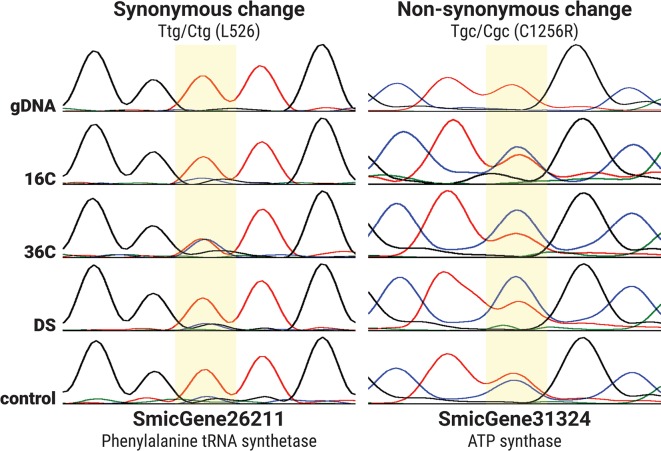
Cycle sequencing peak traces confirming differential RNA editing across different stressors.For brevity, one replicate per condition, and one edit leading to a synonymous change (left) and non-synonymous change (right) are shown. Traces for A, C, G and T are coloured green, blue, black and red respectively. Edited sites are highlighted in yellow; downstream effects of the edits are labelled on top of the highlight (i.e. “Ttg/Ctg” implies a T-to-C edit in the first codon; “C1256R” denotes the non-synonymous change of cysteine to arginine at position 1256 of the amino acid sequence).